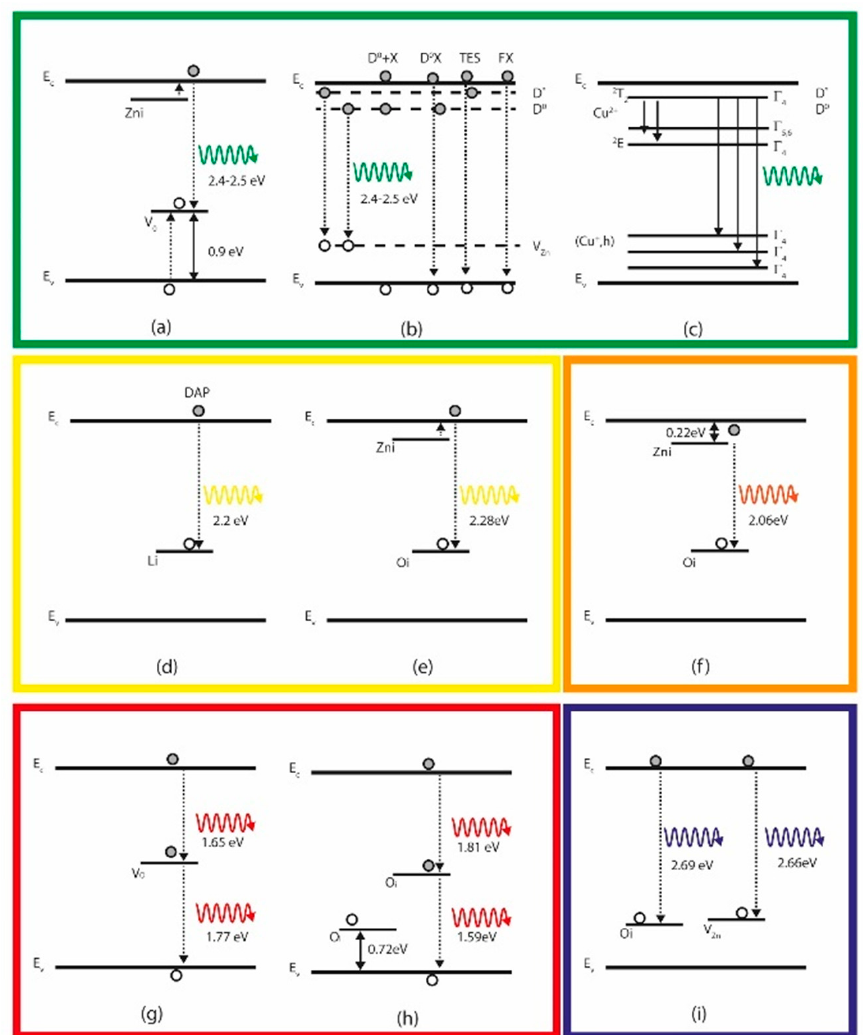
Figure 10. Proposed deep level transition in the different colors indicating the defect involved ( a ) [132], ( b ) [157], ( c ) [154], ( d ) [165], ( e ) [166], ( f ) [134], ( g ) [130], ( h ) [168,169], ( i ) [145,146,149].